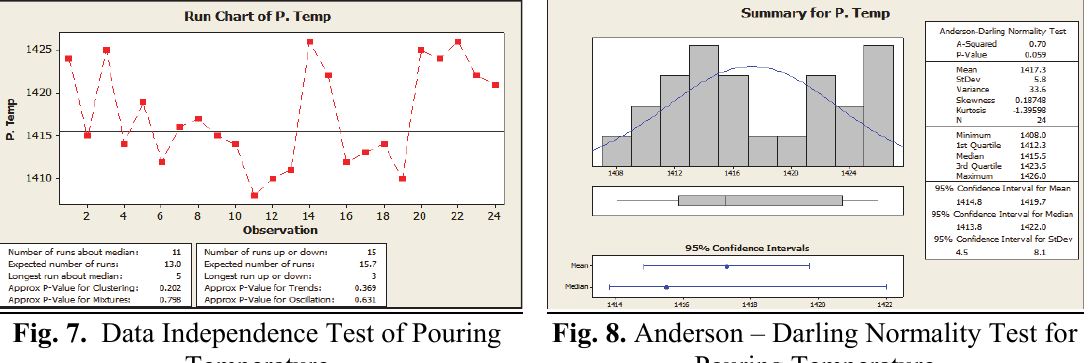
Fig. 7. Data Independence Test of Pouring Temperature